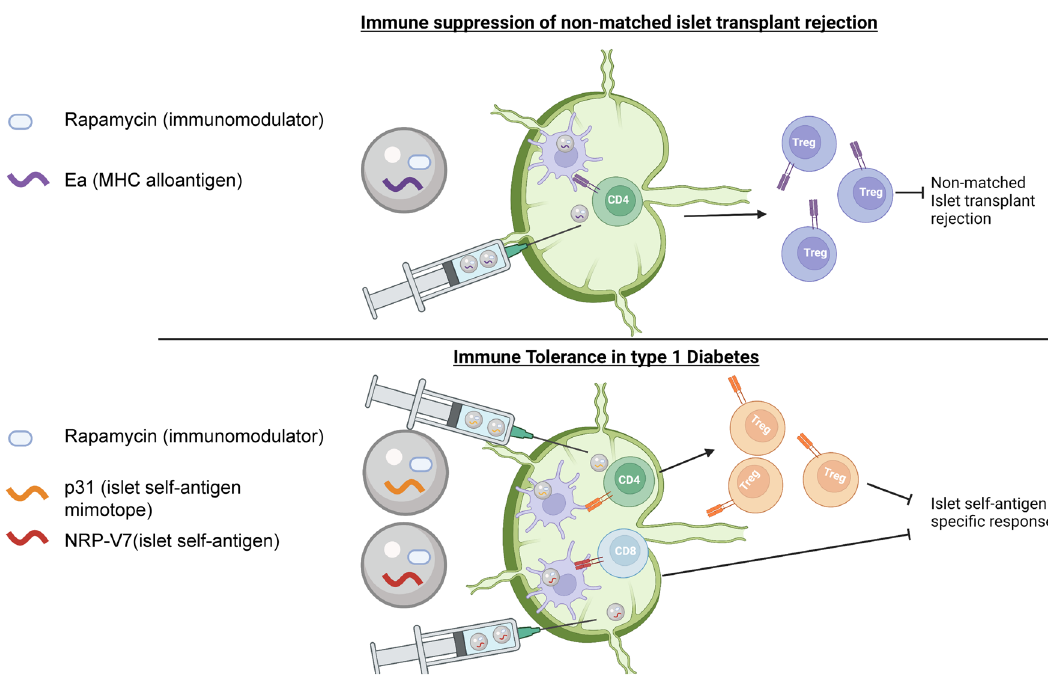
Fig.1|Overviewschematicof iLN microparticledepotstrategytopromotetoleranceinT1Dandallogenicislettransplantation. Intra-lymphnode( iLN ).This fi gure was created with